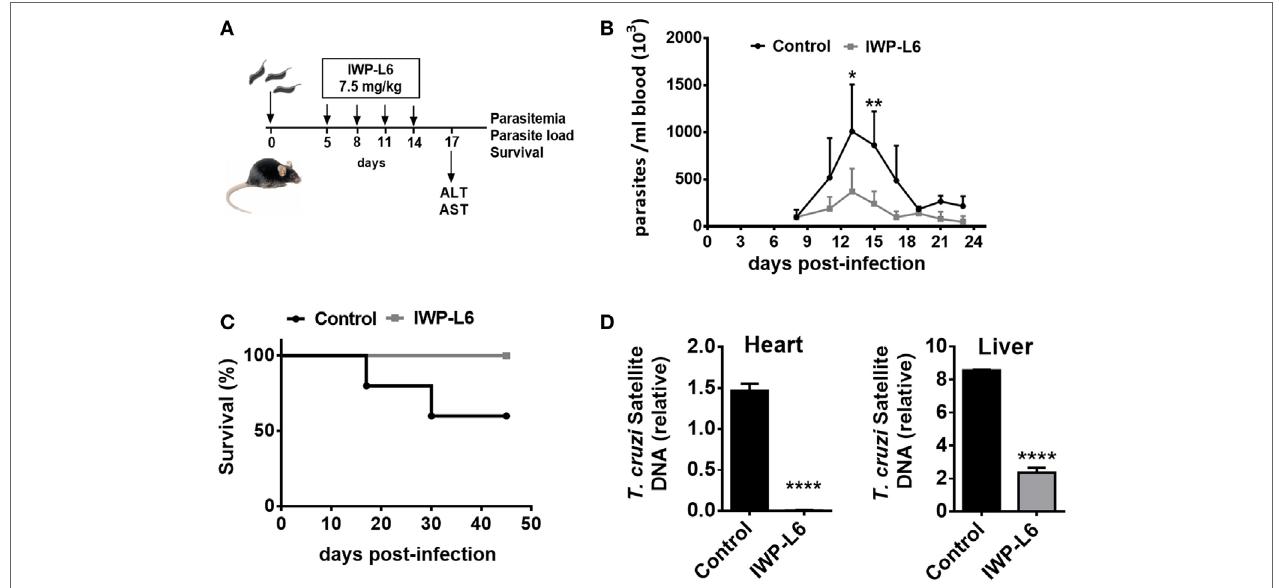
FigUre 7 | In vivo inhibition of Wnt signaling improves the resistance to Trypanosoma cruzi infection. (a) B6 mice infected with 5,000 T. cruzi trypomastigotes were treated with IWP-L6. Vehicle-treated mice were used as control. (B) Parasitemia. Results are means ± SD of 5–6 animals/group and are representative of three independent experiments. (c) Survival rate. Data are representative of one of three independent experiments. (D) Relative amount of T. cruzi satellite DNA in heart and liver from 180-day T. cruzi- infected IWP-L6 and control mice. Murine GAPDH was used for normalization. Data are shown as mean ± SD of triplicates (control, n = 4; IWP-L6, n = 6) mice per group (* P < 0.05; ** P < 0.001; and **** P <